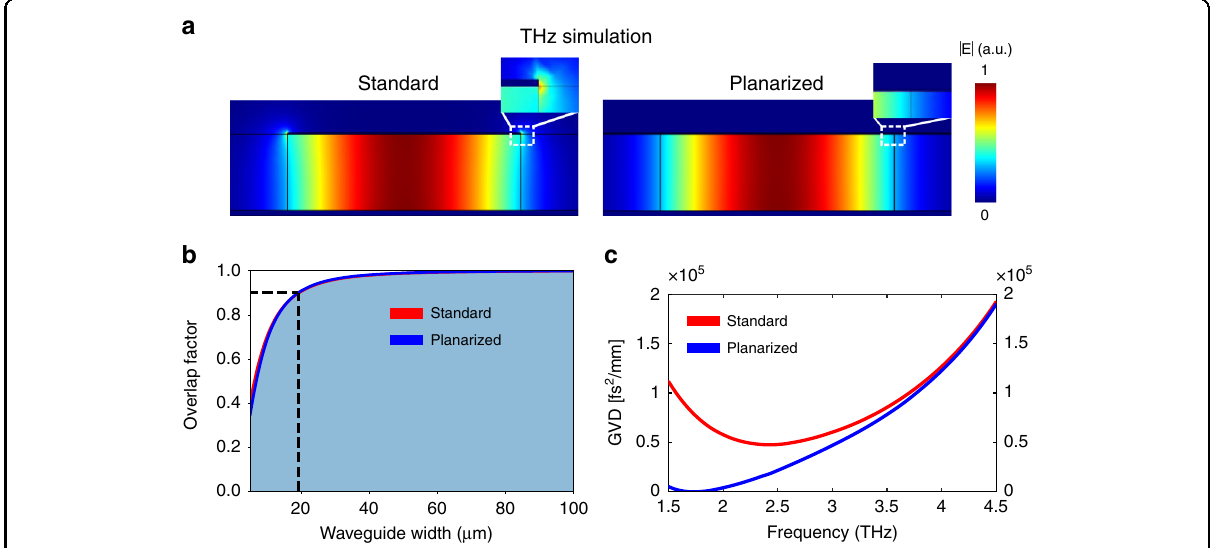
Fig. 2 Numerical simulation results with a comparison of standard and planarized waveguide properties at typical THz QCL frequencies. a COMSOL 2D eigenmode simulation of a 40 μ m wide waveguide at 3 THz. While there are fi eld spikes present in the standard waveguide at the corners, for planarized waveguides the fi eld distribution is smooth also at the environment boundary. b Computed overlap factors with the active region are comparable for the standard and planarized waveguides. The dashed line indicates the width where the overlap factor drops below 90%, for a frequency of 3 THz. c Computed chromatic dispersion for a waveguide width of 40 μ m. At low frequencies (3 THz and below), the